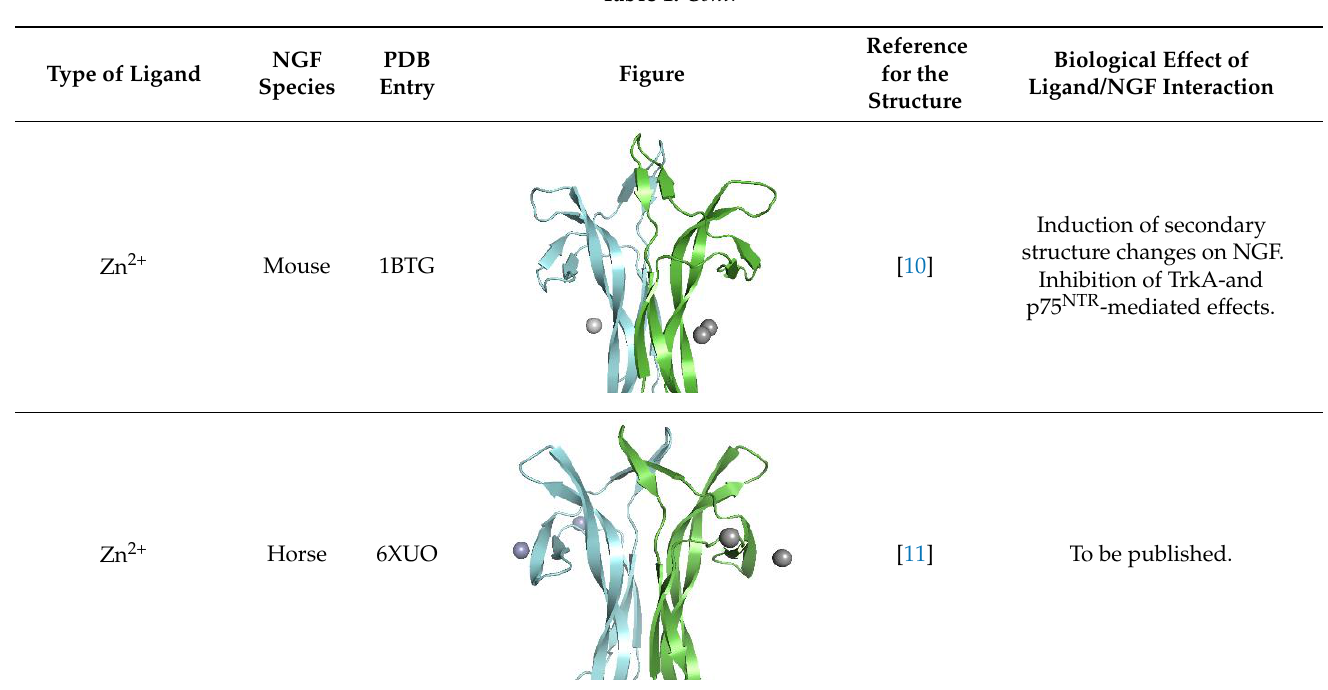
Figure Refer- ence for the Struc- ture Biological Effect of Ligand/NGF Interac-